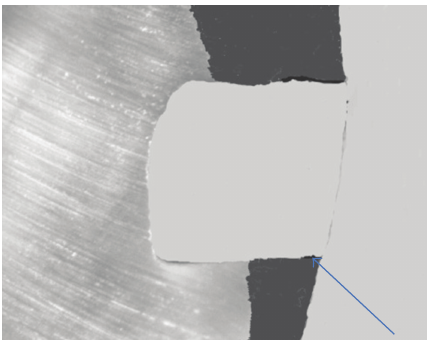
Figure 2: A photomicrograph of the same tooth specimen (Figure 1) showing conversion of color coded image into an 8- bit gray scale image. Arrow is pointing to the area of linear dye